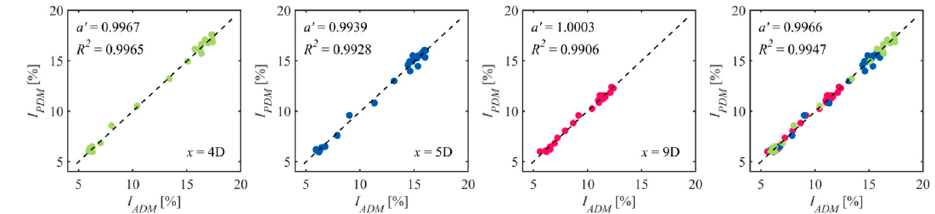
Figure 15. Relationship between the driving modes under the ABL condition in terms of the wake turbulence intensity.